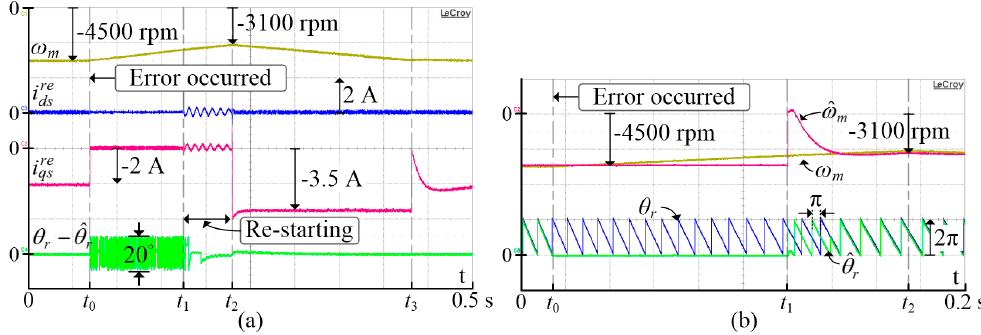
Figure 17. ( a ) Restarting of the motor from θ r = 180° with a negative speed under the rated load; ( b ) Amplified waveforms.